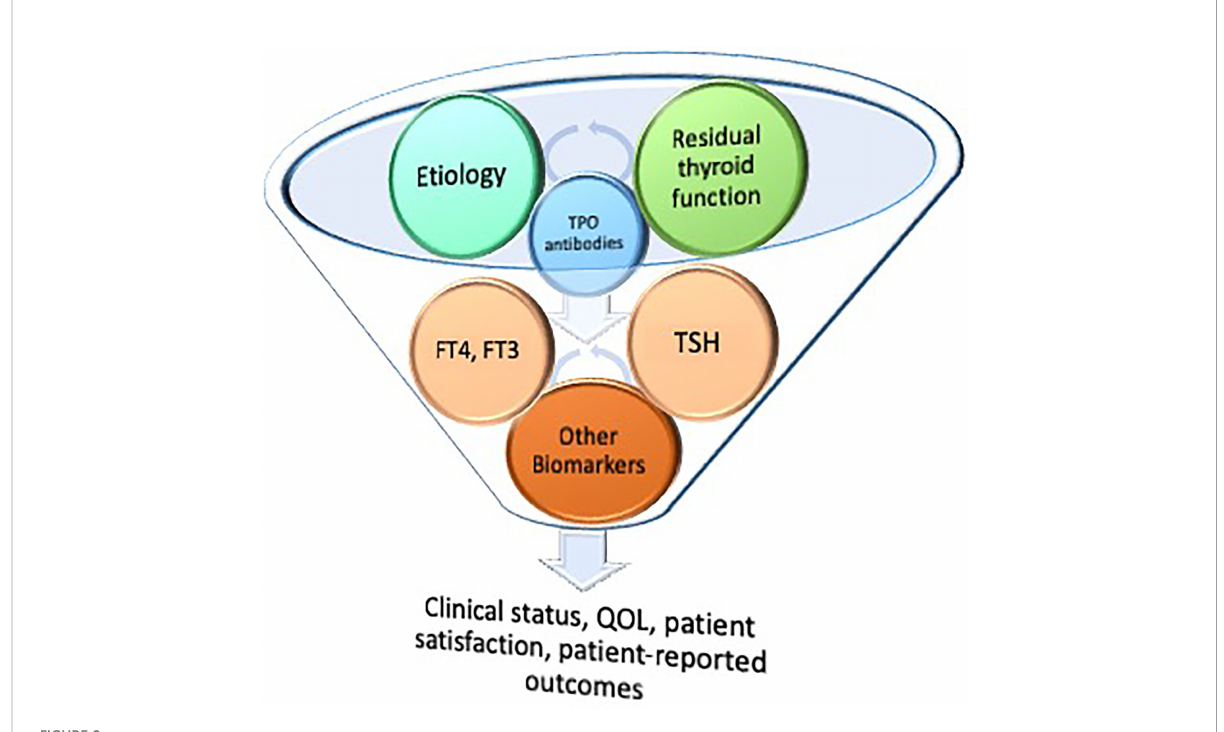
FIGURE 2 Hypothetical interaction between residual thyroid function and etiology of